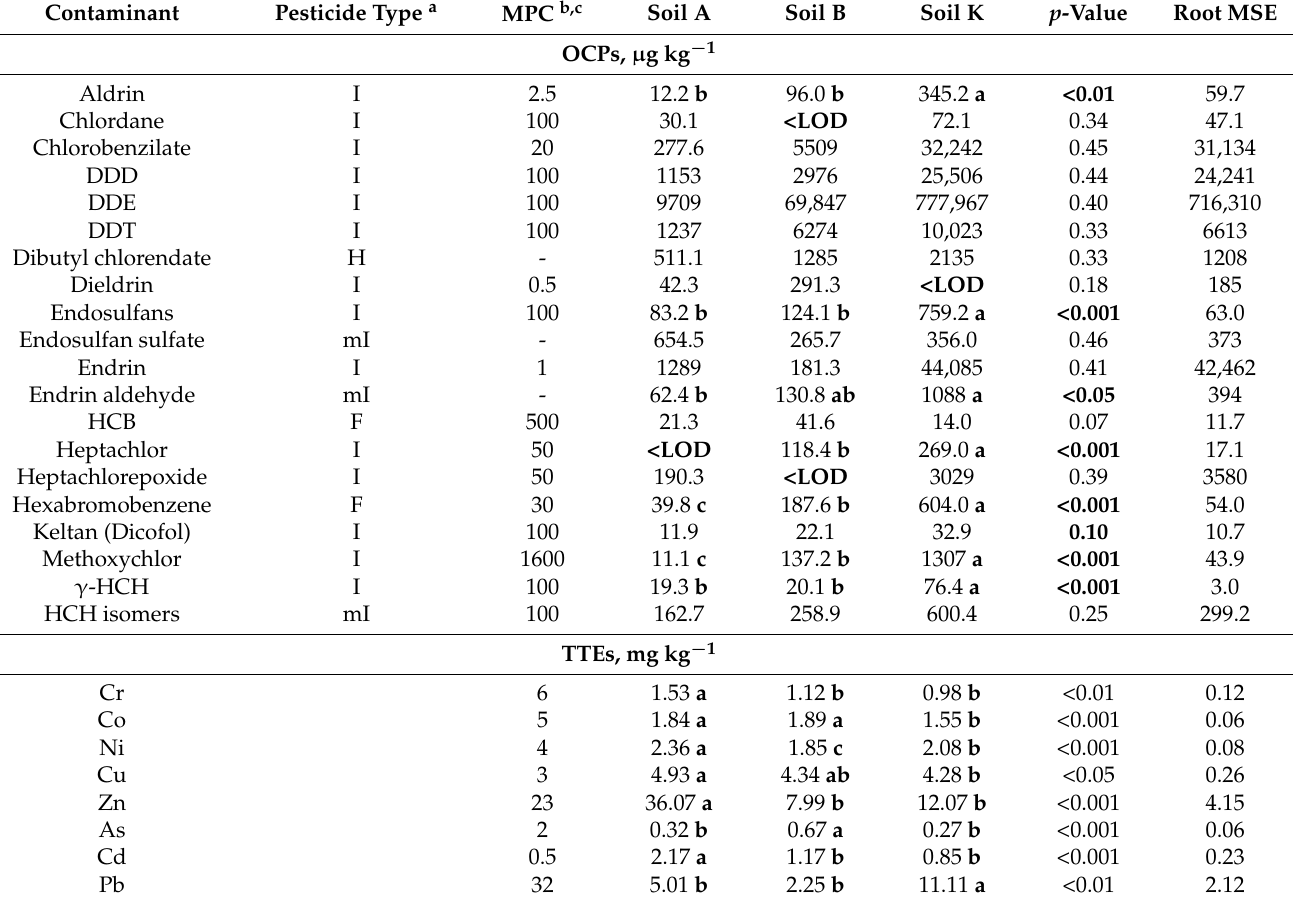
Table 2. Concentrations of OCPs and TTEs in research